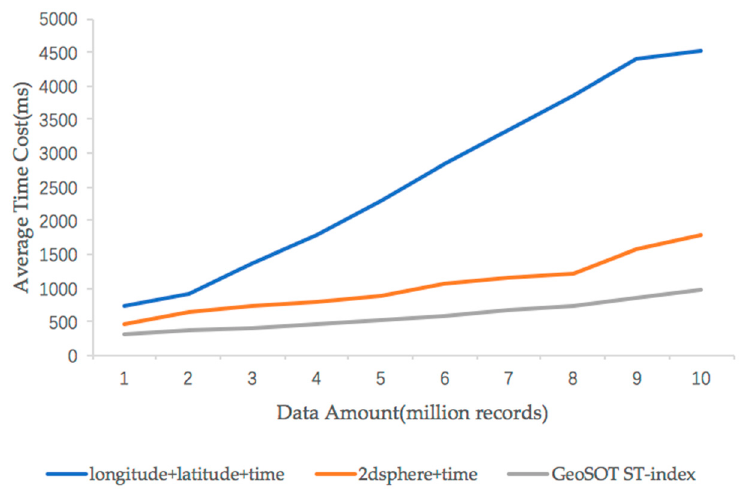
Figure 9. Comparisons of scalability performance.